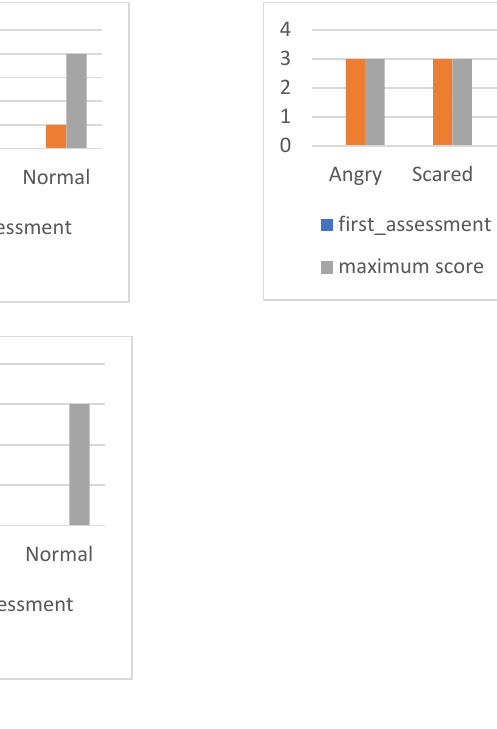
Figure 2. Maria’s ACES subscales : ( a ) facial expressions; ( b ) situations; ( c ) behaviors .